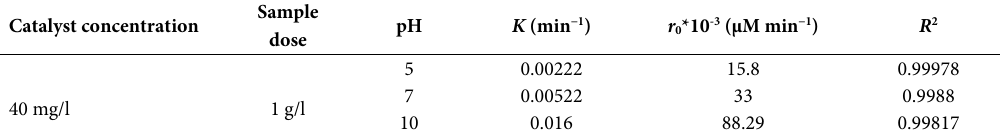
Table 2. displays the kinetic data of BCBD photocatalytic degradation by using MSS sample, at various pH 5, 7 and